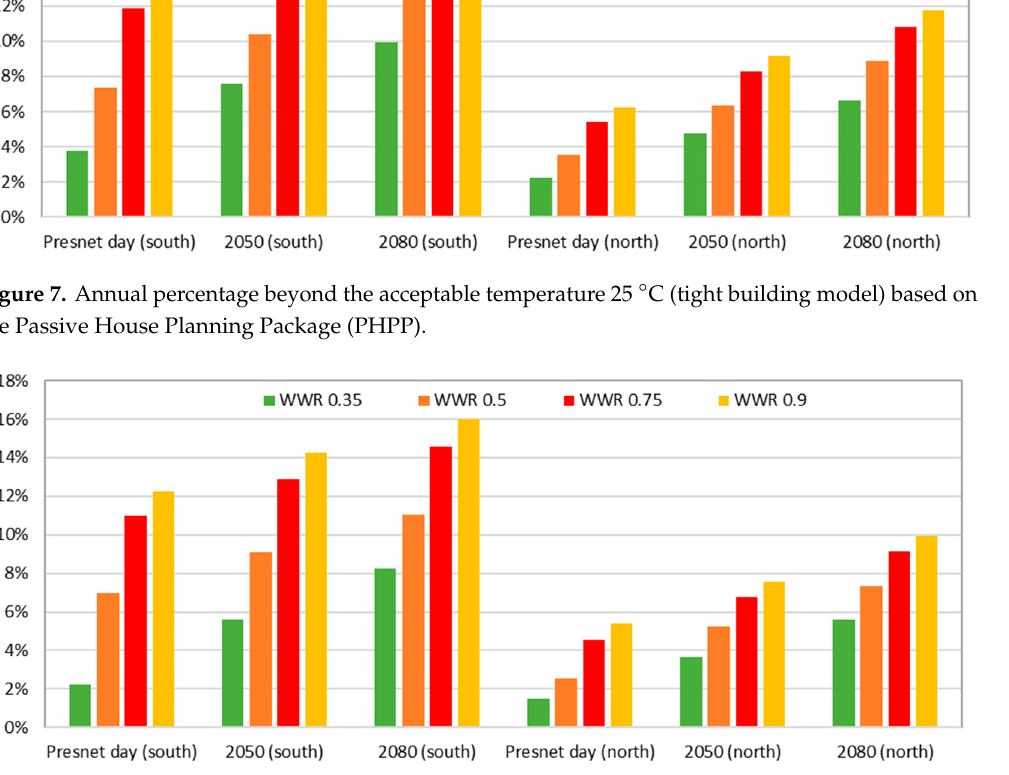
Figure 8. Annual percentage beyond the acceptable temperature 25 °C based on PHPP (average building).